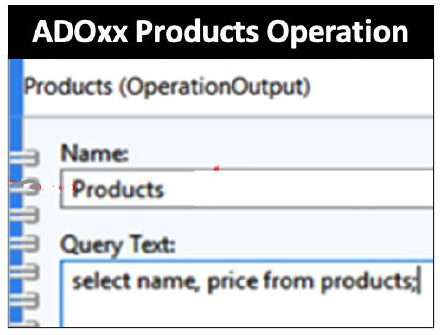
Figure 5. Attaching queries to diagram elements that represent database Operations